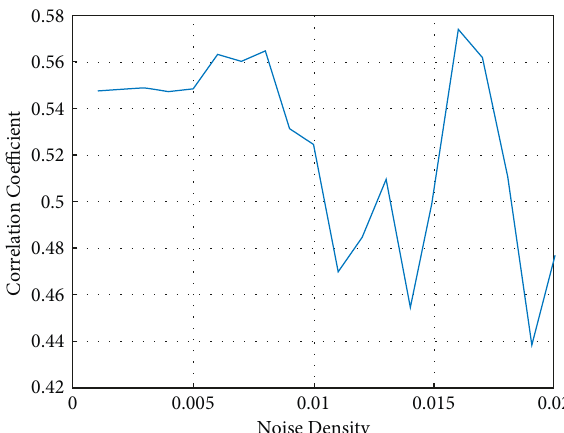
Figure 9: Performance comparison based on noise